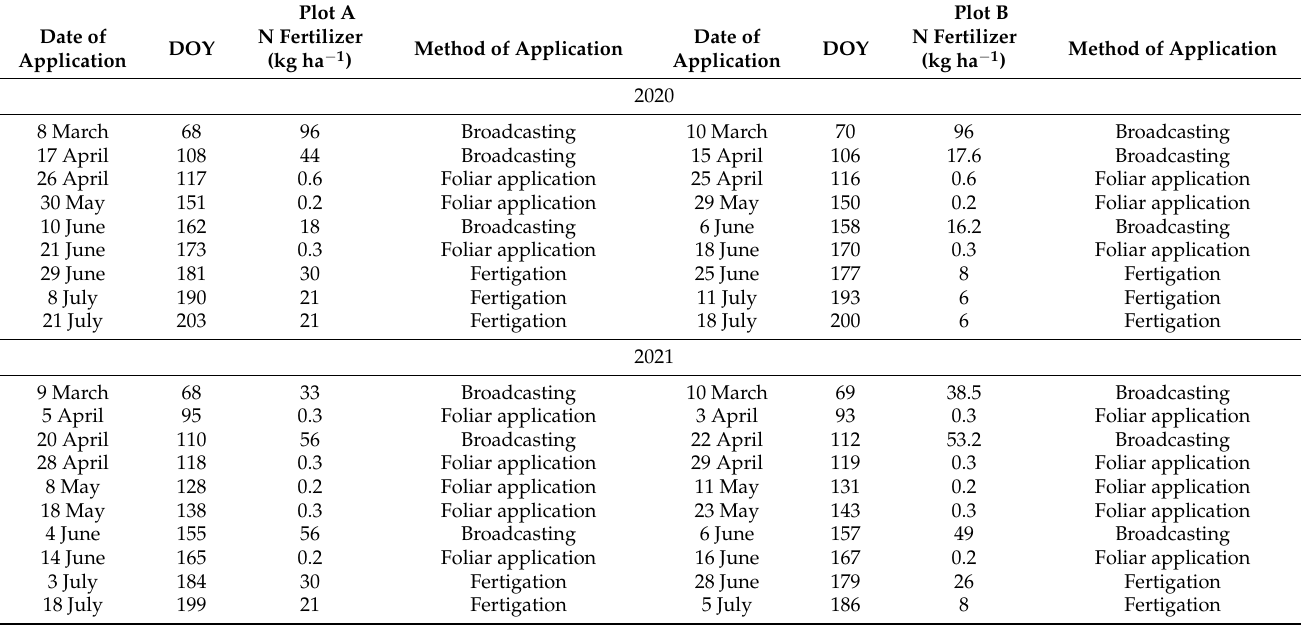
Table 4. Nitrogen fertilization management calendars for both plots under study in 2020 and 2021 (DOY: Day of